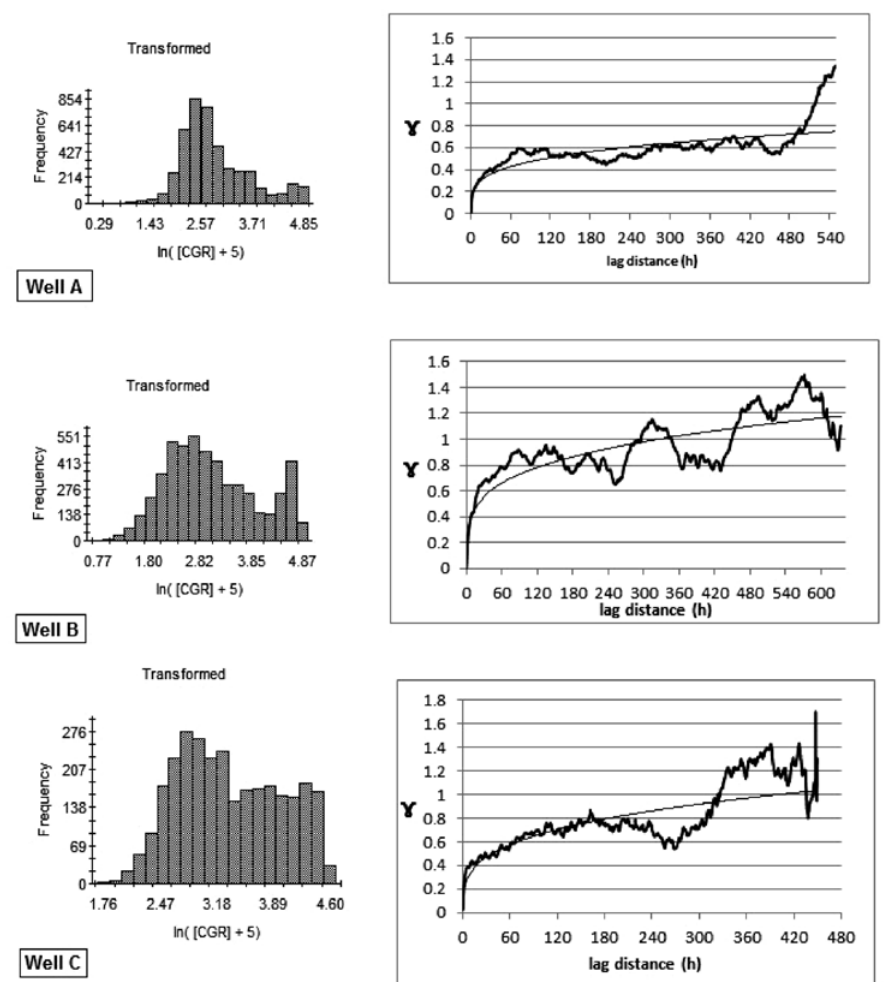
Fig. 7. Histograms and Variograms of studied